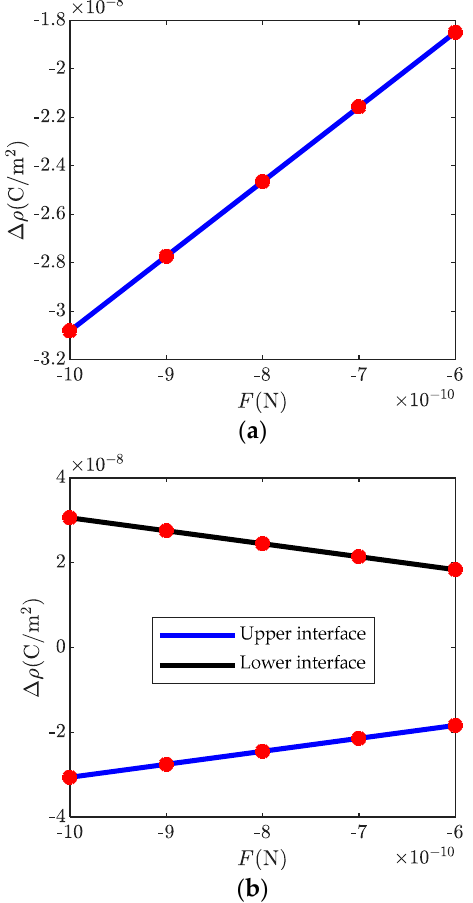
Figure 5. The polarized charges vs. transverse shear forces: ( a ) bi-layer, ( b ) three-layer.